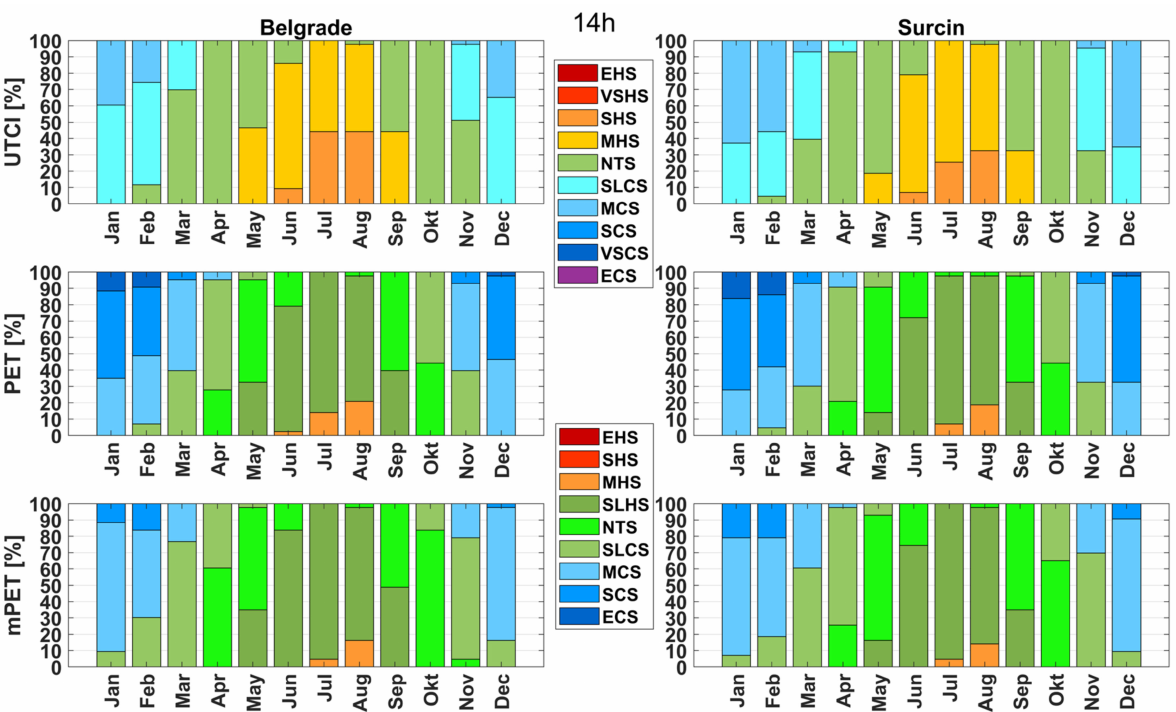
Figure 3. Monthly frequencies (expressed in percentages) of the represented thermal stress classes of all three PET, mPET and UTCI indices in Belgrade and Surcin at 14